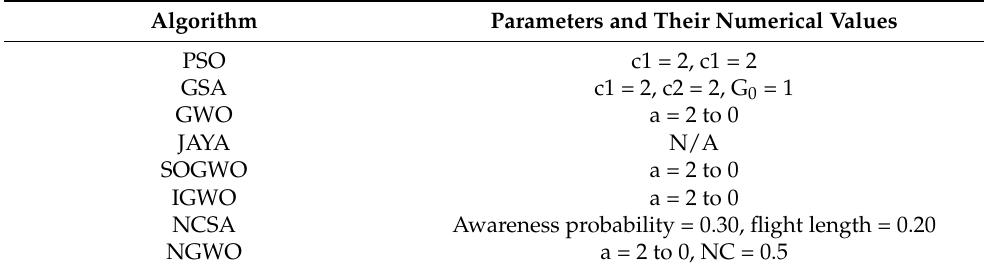
Table 2. Parameters of the compared algorithms.